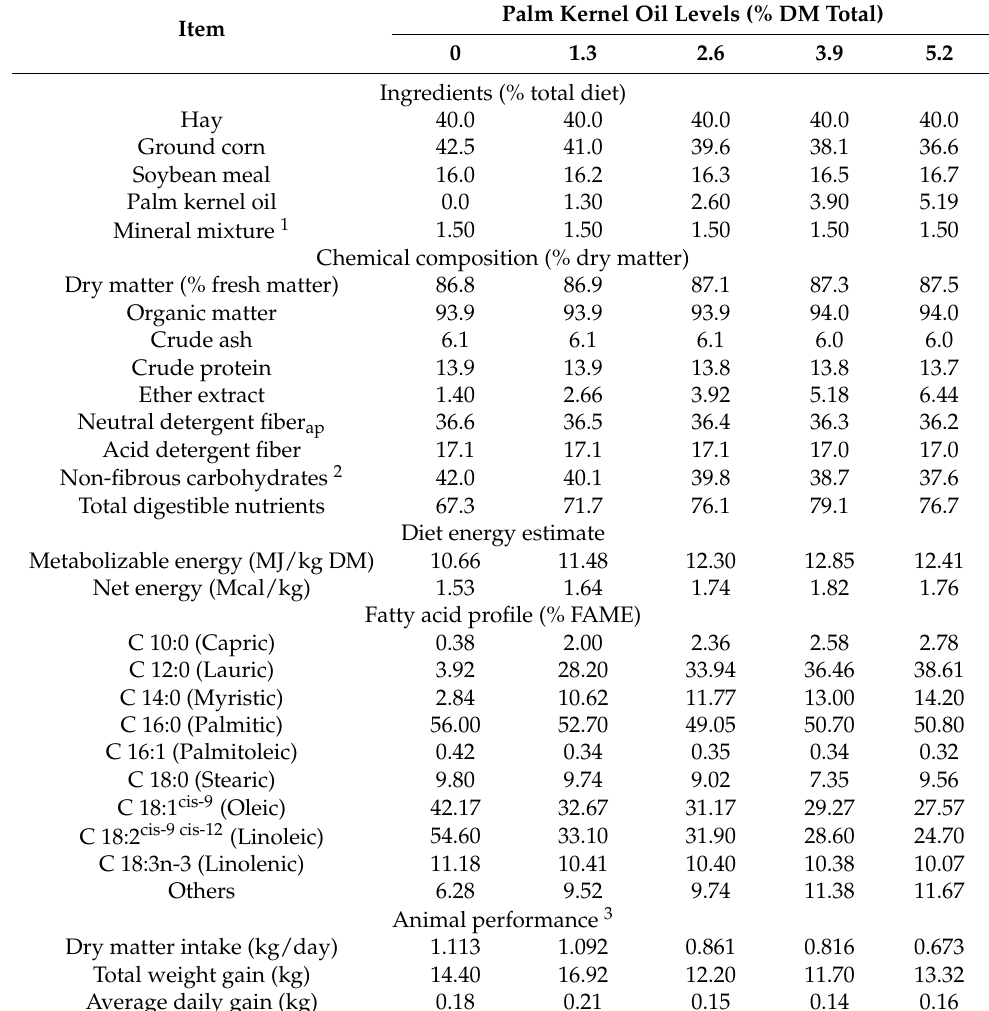
Table 1. Ingredients proportion, chemical composition, fatty acid profile and animal performance of the experimental